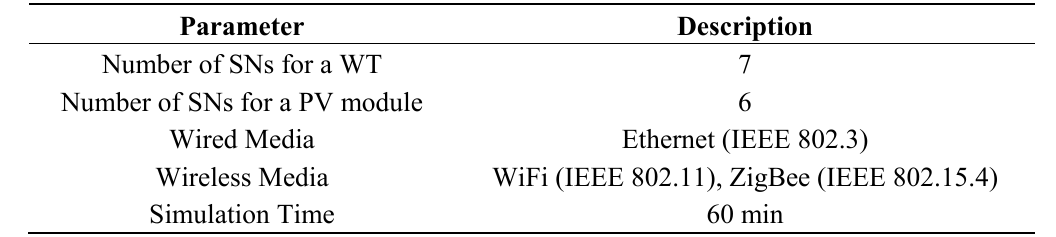
Table 6. OPNET simulation assumptions; SN: Sensor Node.